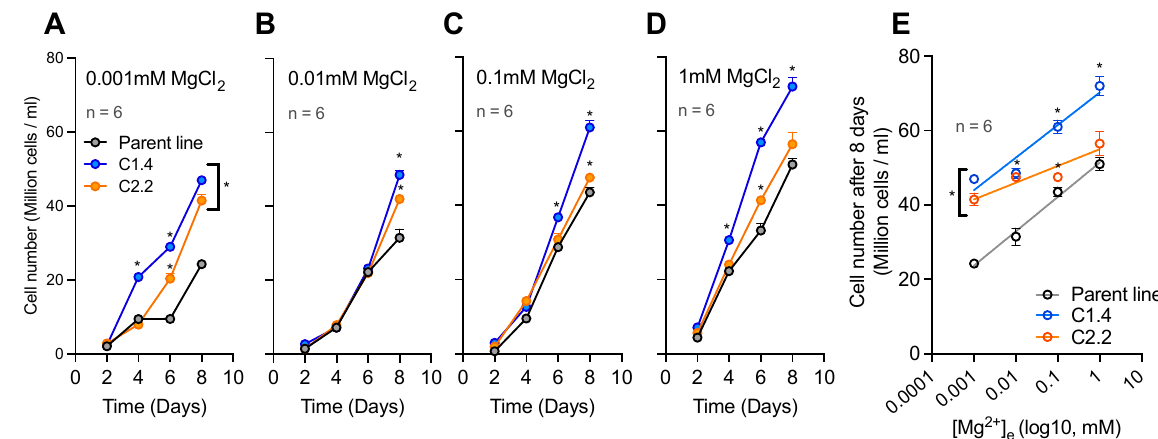
Figure 5. CNNM activity rescues cell proliferation under magnesium depletion. Cell growth time series under LL for the parent line, CNNM1ox, and CNNM2ox subjected to low-Mg media: 0.001mM ( A ), 0.01mM ( B ), 0.1mM ( C ), and 1mM ( D ) MgCl 2 . ( E ) Cell counting after 8 days of exposure to low-Mg media. Data are presented as the mean ± SEM. n = technical replicate number. * = p < 0.0001; statistical analyses are compared with the parent line; two-way ANOVA.